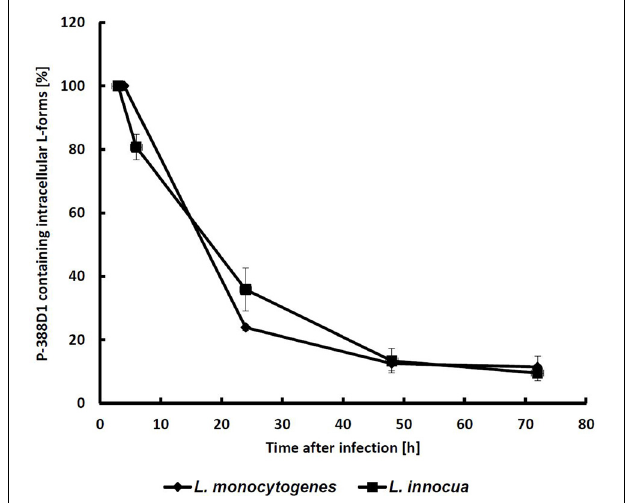
FIGURE 2 | Monitoring of GFP-labeled intracellular L-forms (ICL) in P-388D1 macrophages. After 3h p.i. approx. 1.2% of the macrophage population featured intracellular L-forms, which was set as the initial 100% value. Fate of the ICL was monitored for 72h. Values represent the means of five microscopic fields in two replicate experiments. Standard deviation is indicated by error bars.